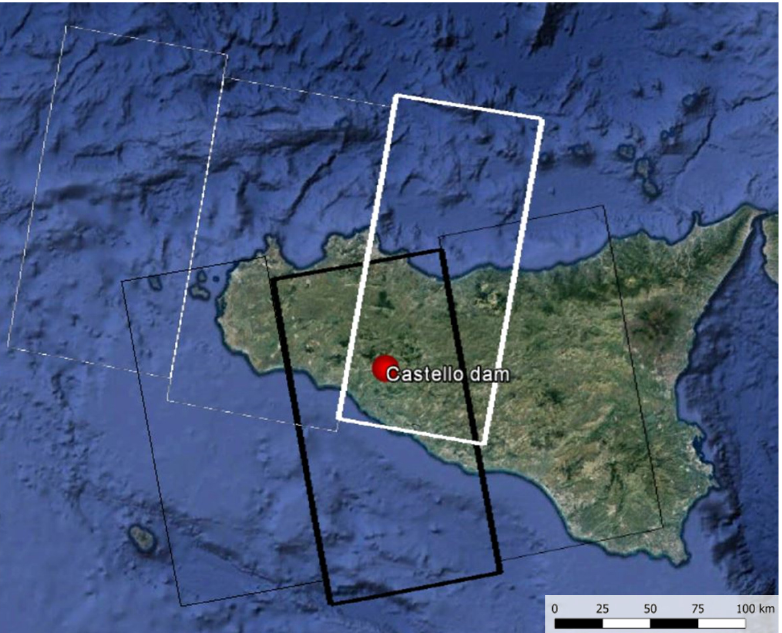
Figure 2. The Terrain Observation with Progressive Scans SAR (TOPSAR) S-1A track over Google Earth: ascending orbit (relative orbit number 117, sub-swath IW2, thick black box) and descending orbit (relative orbit number 22, sub-swath IW1, thick white box). Other sub-swaths are represented with thin black and white lines (ascending and descending orbits, respectively). The position of the Castello dam is indicated (red dot).